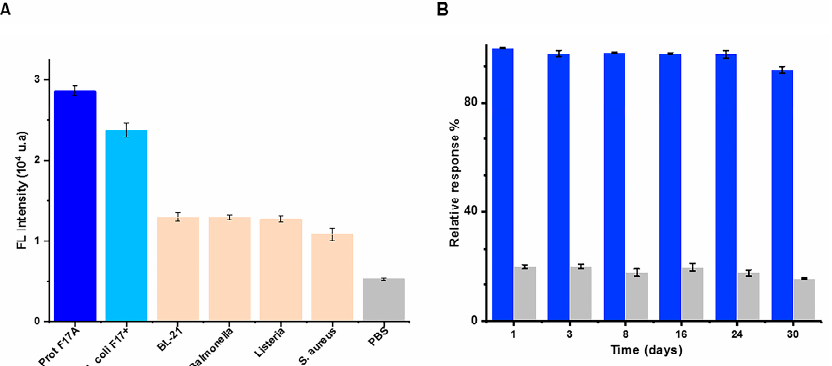
Figure 3. ( A ) Fluorescence intensity for selectivity evaluation obtained with Salmonella , Listeria , Staphylococcus , and E. coli BL21-DE3 . ( B ) Storage stability of MB-Nb1 based on fluorescence signals measured in the absence and in the presence of the F17-positive E. coli strain ( n = 3).